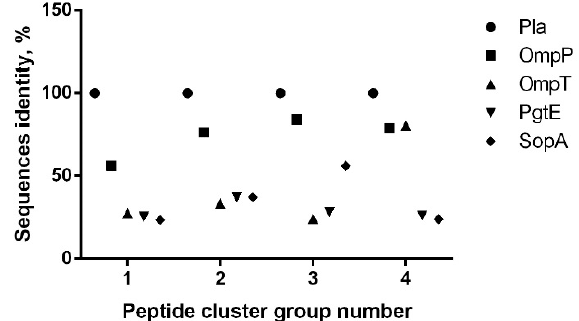
Figure 2. Identification of four major reactive epitopes within the pro-omptin molecule and their homology with other omptin family proteases. Percent homology between amino acid sequences of Pla versus other omptins in four immunodominant regions mapped via immunoreactive peptides.